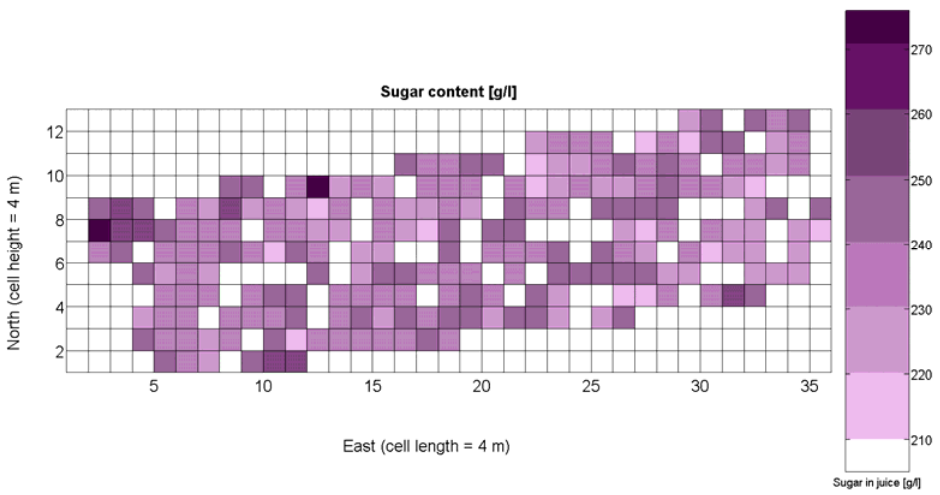
Figure 10. CB map of sugar content in must (º